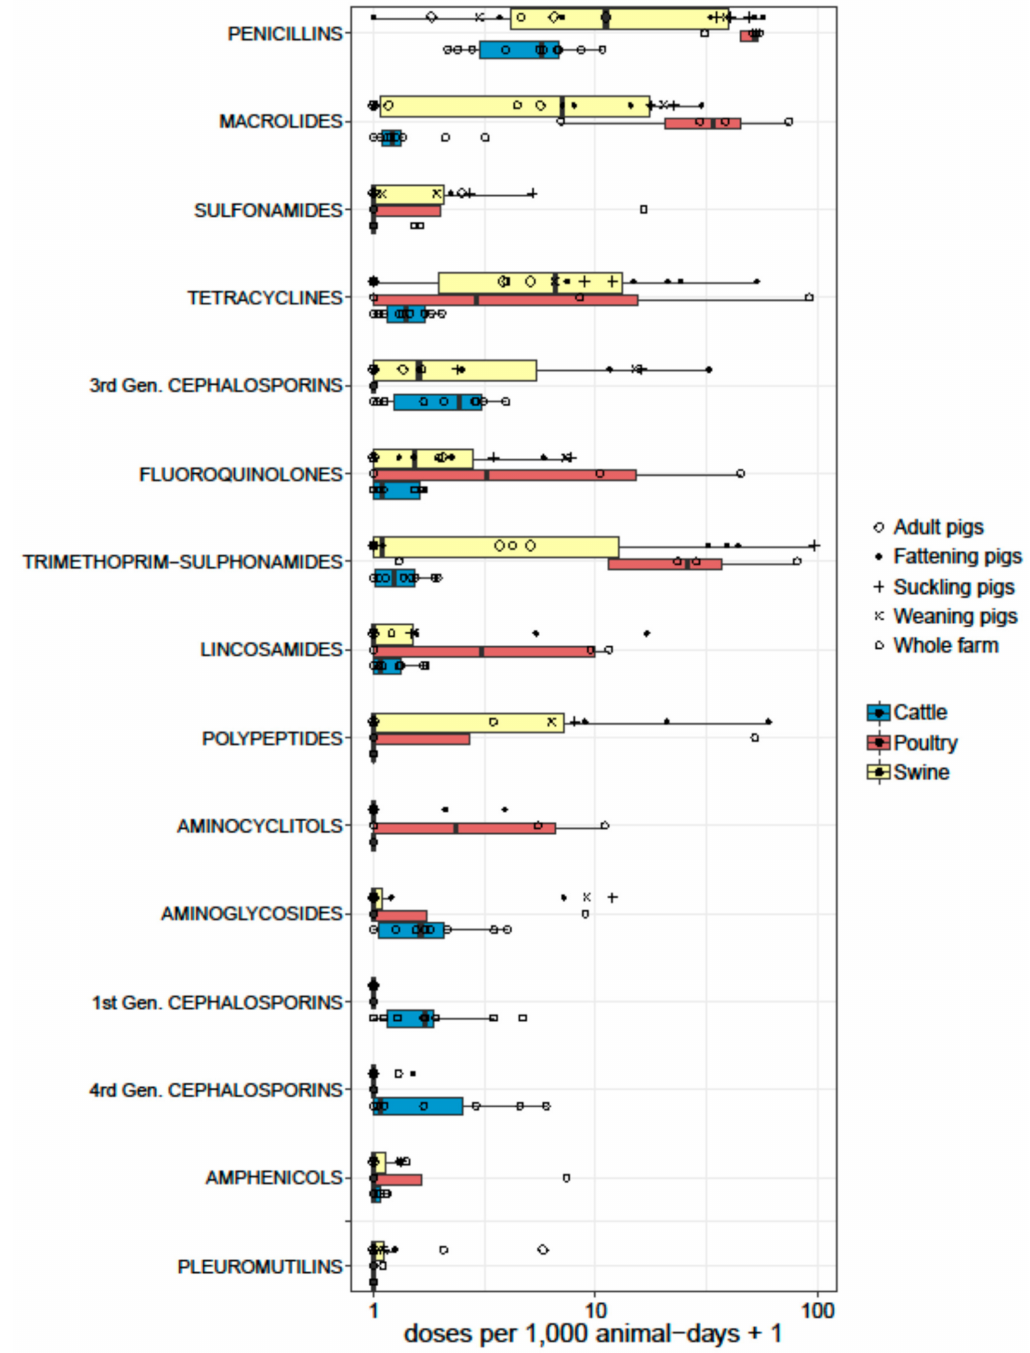
Figure 3. Boxplots representing the summary of AMU by antimicrobial classes from studies reporting quantitative data as doses (per 1000 animal-days) in swine (15), dairy (10), and poultry (4) farms. The thickness of the boxes reflects the number of